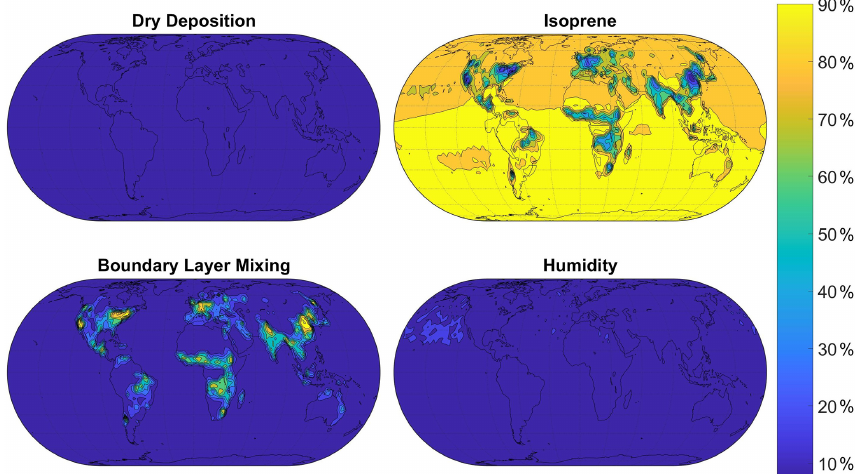
Figure 6. Sensitivity indices representing the percentage of the variance in surface CO in the FRSGC/UCI model output due to changes in each input parameter. Maps of sensitivity indices for the other four parameters are shown in Fig. S3 of the